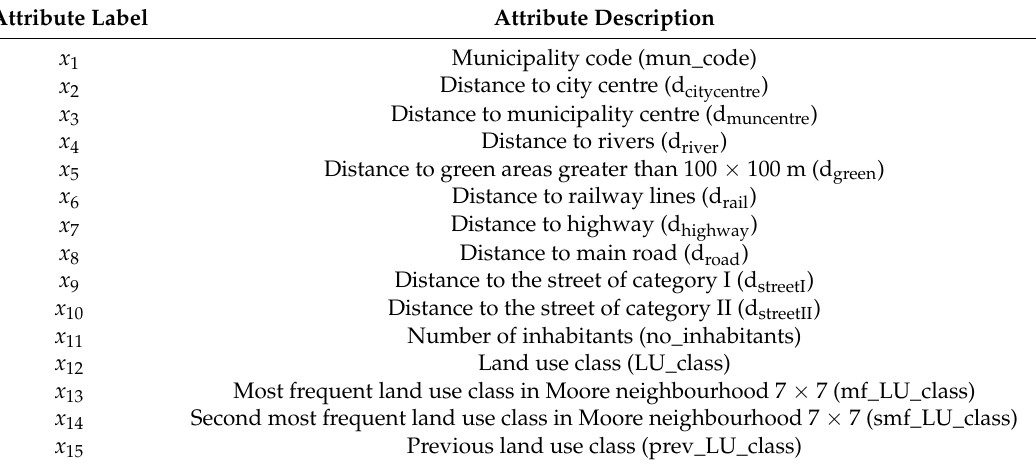
Table 1. List of attributes used for modeling land-use change in the study area.